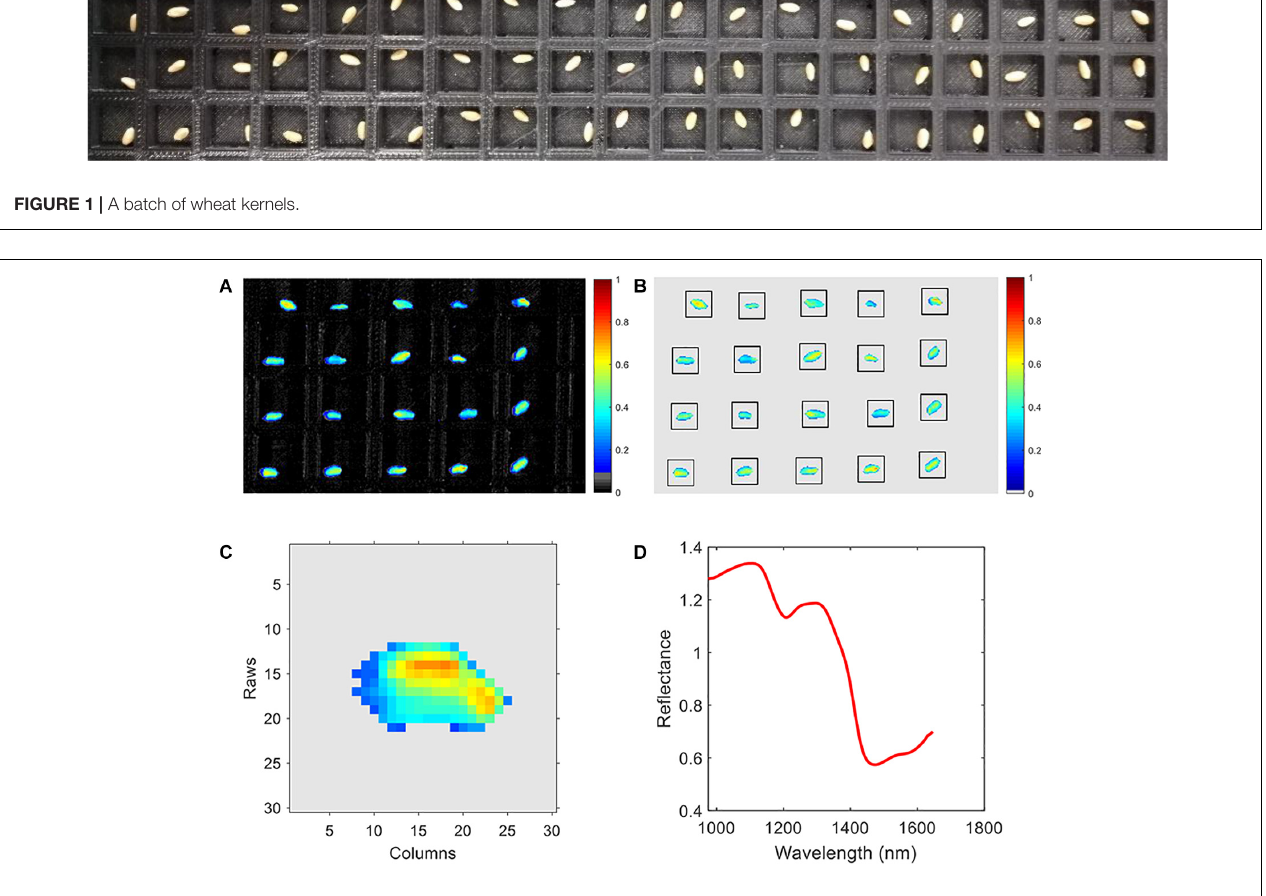
FIGURE 2 | Spectral data pre-processing. (A) Pseudo-image of the raw spectral image with background, (B) pseudo-image of the spectral image without background, (C) pseudo-image of an individual wheat kernel, and (D) the mean spectra of the wheat kernel in (C)